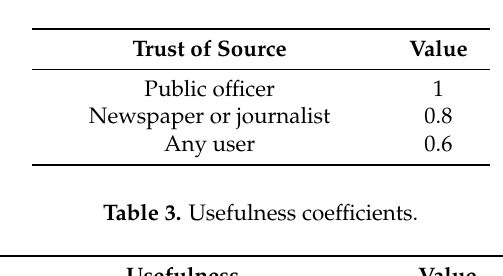
Table 2. Trust of source coefficients.